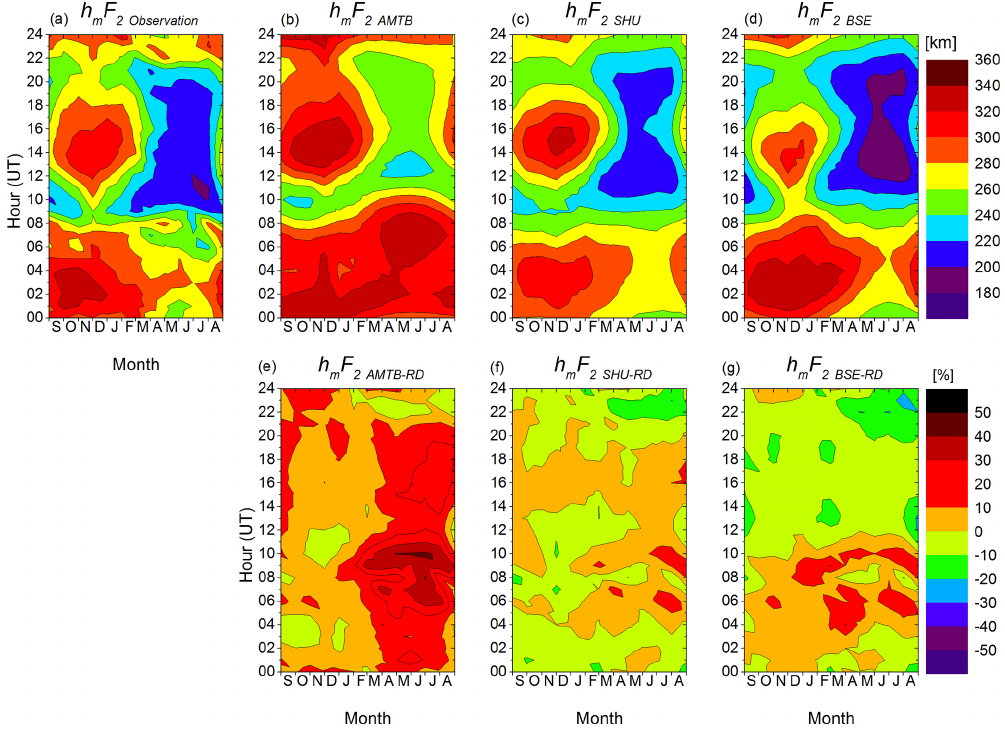
Figure 3. Contour plot of the monthly averaged hm F2 (a) measured by the Santa Maria digisonde (SMK29), provided by (b) AMTB, (c) SHU, and (d) BSE coefficients. The respective relative deviation ( R D ) in percent is placed in the lower panels for (e) AMTB, (f) SHU, and (g) BSE.